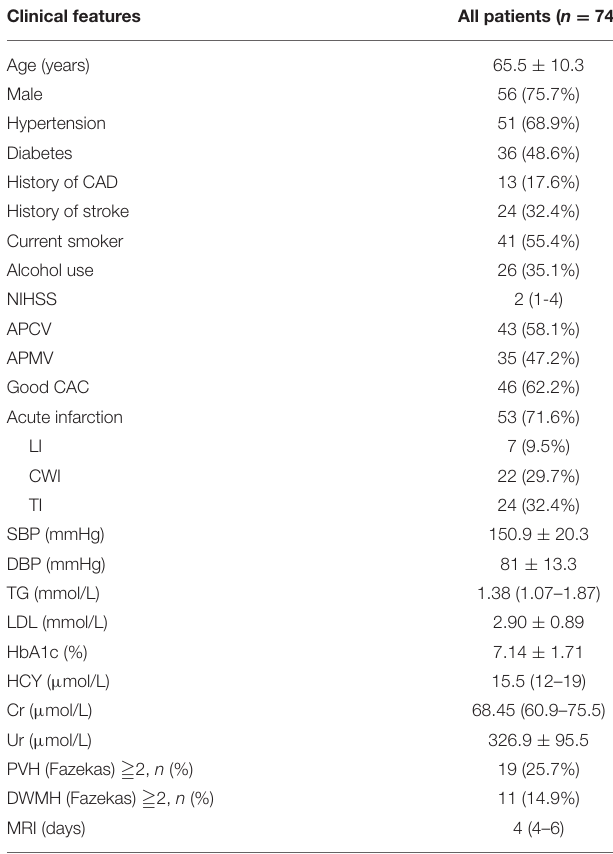
TABLE 1 | Baseline characteristics of enrolled